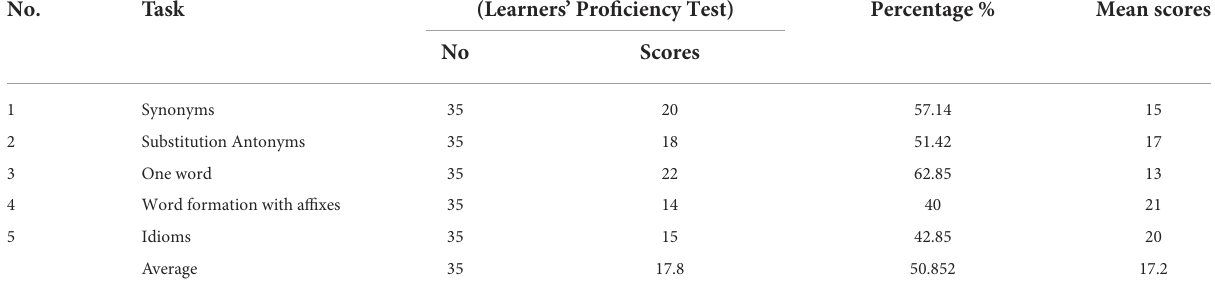
TABLE 1 Learners’ knowledge of lexemes.